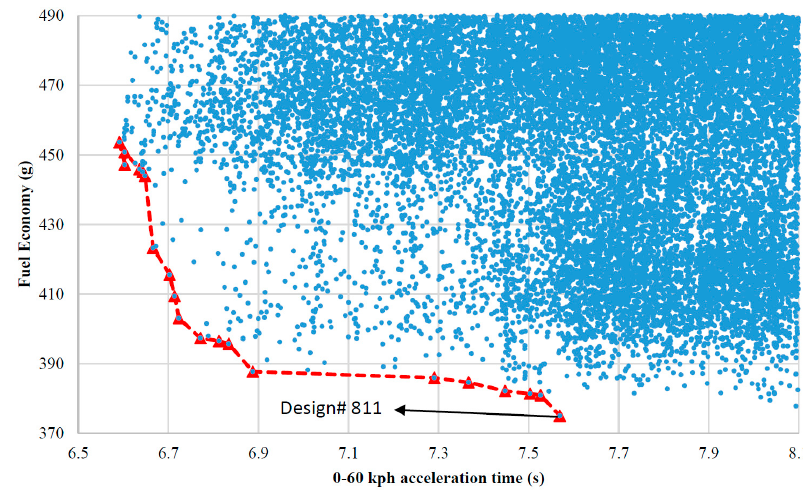
Figure 8. Results of nested optimization where red line is the Pareto-optimal. Table 2. Performance improvement of the hybrid bus before and after nested optimization.